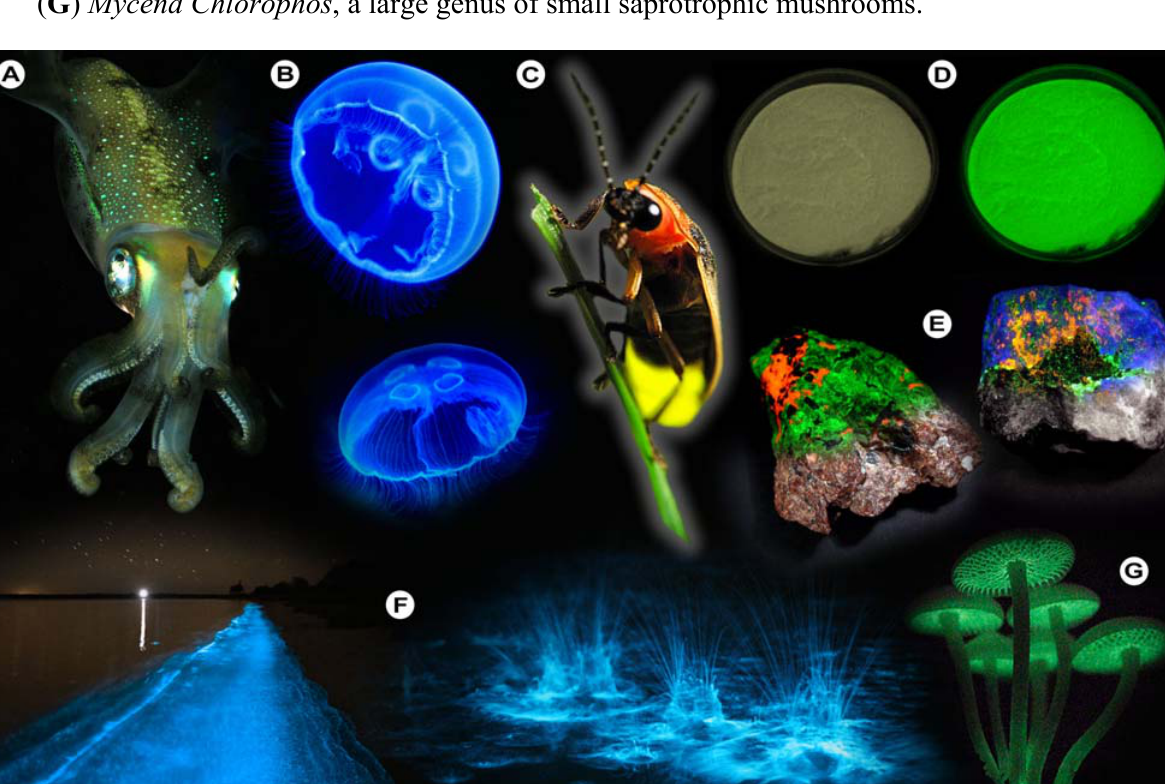
pigment (alkaline earth metal); ( E ) Fluorescent rocks (top is illuminated with UV-light; bottom white light recording): left = Willemite/Calcite; right = Hardystonite (courtesy